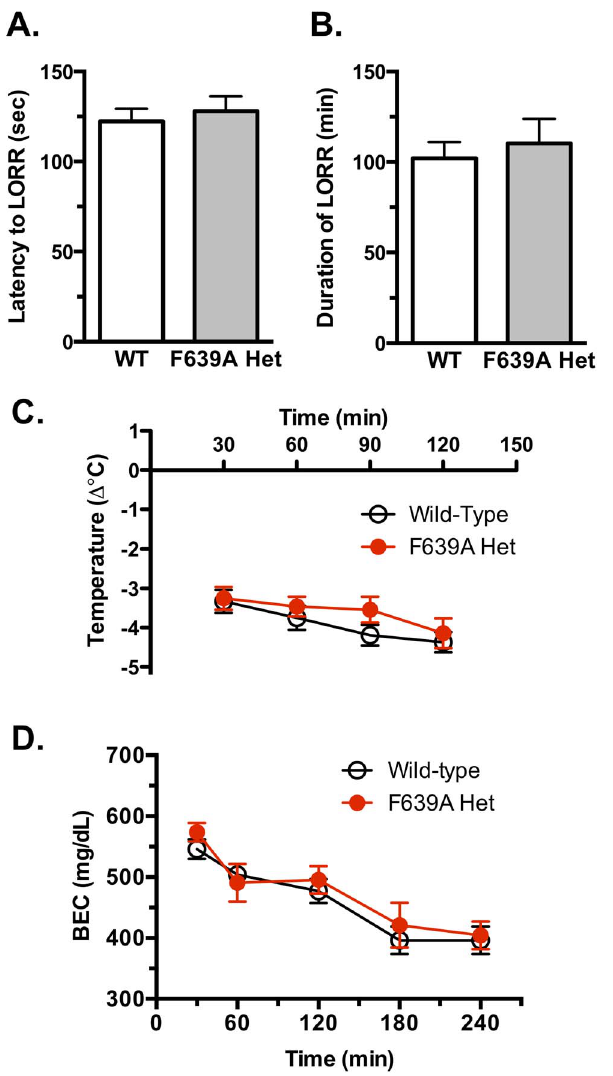
Figure 5. Hypnotic and hypothermic effects of high doses of ethanol. Latency to lose righting reflex (LORR; A ) and duration of LORR ( B ) following a 4.0 g/kg injection of ethanol in wild-type and F639A Het mice (n=17–18 for each group). Values are mean 6 SEM. ( C ), Change in body temperature following a 3.5 g/kg injection of ethanol in wild-type and F639A Het mice (n=10 for each group). Values are mean 6 SEM. ( D ), Rate of blood ethanol metabolism between wild-type and F639A Het mice. Blood ethanol concentration (mean 6 SEM) measured over time following injection with 4.0 g/kg of ethanol (n=7 for each group). doi:10.1371/journal.pone.0080541.g005 (two-way ANOVA: effect of treatment, F (1,36) = 4.67, p , 0.05; Figure 6B) and total arm entries in both groups, although the latter measure did not quite reach statistical significance ( p = 0.06; Figure 6C). No genotypic differences in total number of arm entries and total distance traveled were observed in either saline- or ethanol-treated wild-type and F639A Het mice.